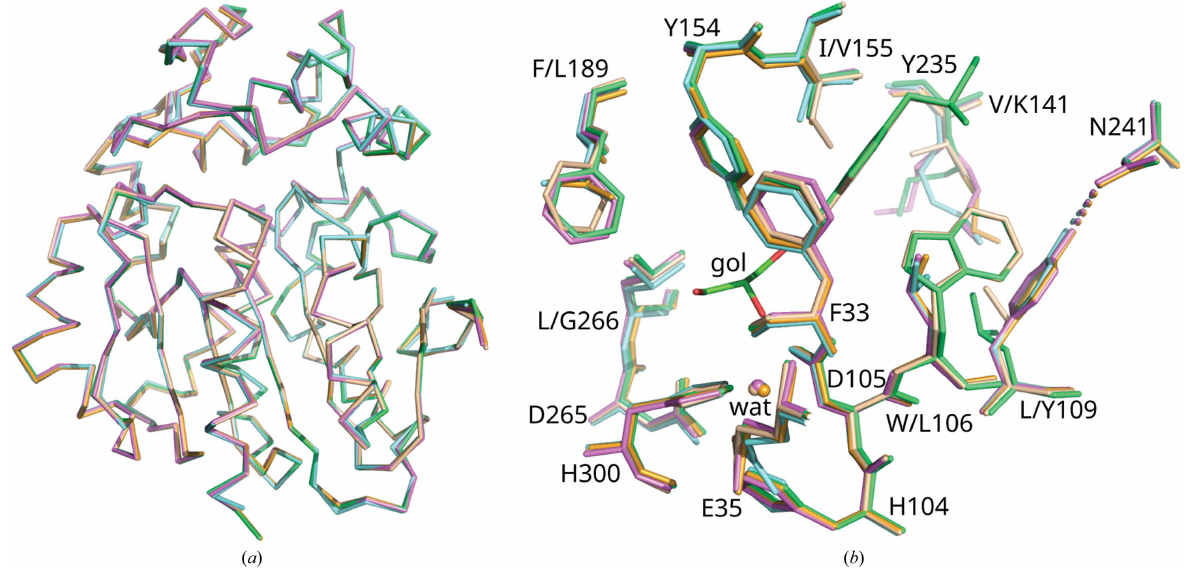
Figure 4 Structures of the enzyme variants analyzed in this work. ( a ) Superposition of the C (cid:2) traces of wild-type StEH1 (wheat) and the variants R-C1 (lime green), R-C1B1 (violet), R-C1B1D33 (aquamarine) and R-C1B1D33E6 (orange). ( b ) Overlay of active-site residues, including those that differ between the different enzyme variants. The catalytic residues are Asp105 (nucleophile), His300 (general base), Asp265 (charge relay) and Tyr154 and Tyr235 (acids) (see Fig. 1 for the full reaction mechanism). Glu35 and His104 are auxiliary catalytic residues. The hydrolytic water (wat) is also shown. A glycerol molecule (gol) bound in the active site of R-C1 has been included to show the substrate-binding pocket. The residue replacements are given in Table 2. The modelled side-chain conformations of Lys141 should be considered arbitrary owing to a lack of clear electron density beyond C (cid:4) . This figure was constructed from the atomic coordinates in PDB entries 2cjp (wild type; Mowbray et al. , 2006), 4uhb (R-C1; Janfalk Carlsson et al. , 2016), 4ufn (R-C1B1; Bauer et al. , 2016), 4ufp (R-C1B1D33; Janfalk Carlsson et al. , 2016) and 4ufo (R-C1B1D33E6; Janfalk Carlsson et al. , 2016) using PyMOL v.1.8.7.